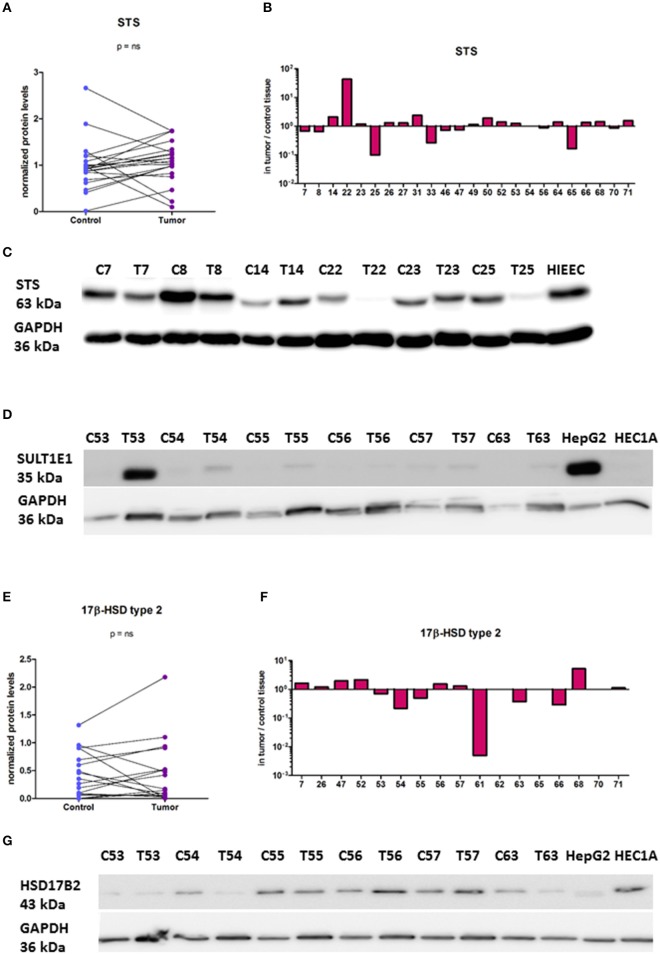
Protein levels of STS, SULT1E1, and HSD17B2 in the EC and adjacent control tissue. (A) Before-and-after graph shows STS protein levels in 24 paired samples of control endometrium (Control) and corresponding cancer tissue (Tumor). The data was quantified and normalized to GAPDH levels. (B) Histogram with logarithmic scale demonstrates higher STS levels in cancer endometrium in 12 paired samples out of 24. (C) Representative membrane with STS and GAPDH staining. (D) Representative membrane with SULT1E1and GAPDH staining. (E) Before-and-after graph shows HSD17B2 protein levels in 17 paired samples of control endometrium (Control) and corresponding cancer tissue (Tumor). The data was quantified and normalized to GAPDH levels. (F) Histogram with logarithmic scale demonstrates protein ratio between paired samples of tumor and control tissue. (G) Representative membrane with HSD17B2 and GAPDH staining. C, control endometrium; T, EC tissue; HIEEC, control epithelial cell line of normal endometrium; HEC1A, endometrial cancer cell line; HepG2, liver cancer cell line.